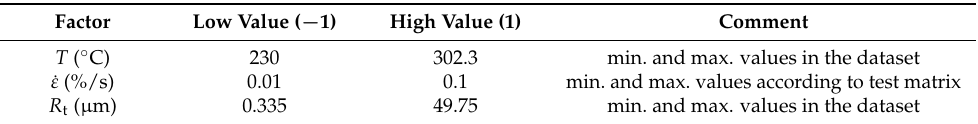
Table 9. Normalization of the factors T and ˙ ε for the tests at reduced F en .